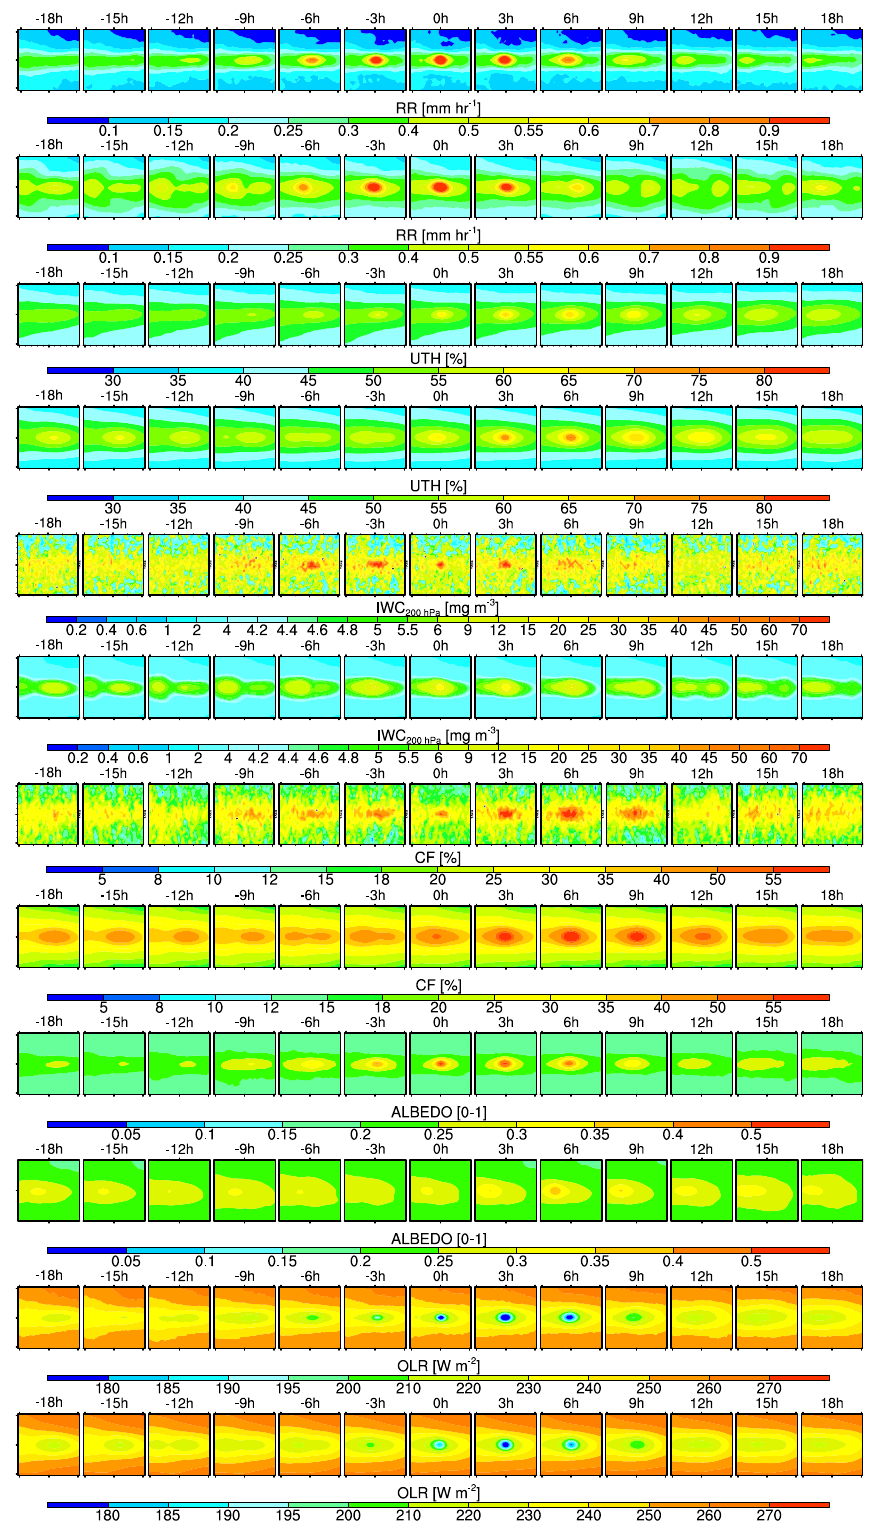
Fig. 3. Composite mean friezes for RR, UTH, IWC, CF, albedo, and OLR. CF and IWC are given for 200hPa. The time bins between ± 18h are shown and the spatial size of each plot is a 12 ◦ × 12 ◦ box. For each frieze pair, observations are on top and the model is given directly